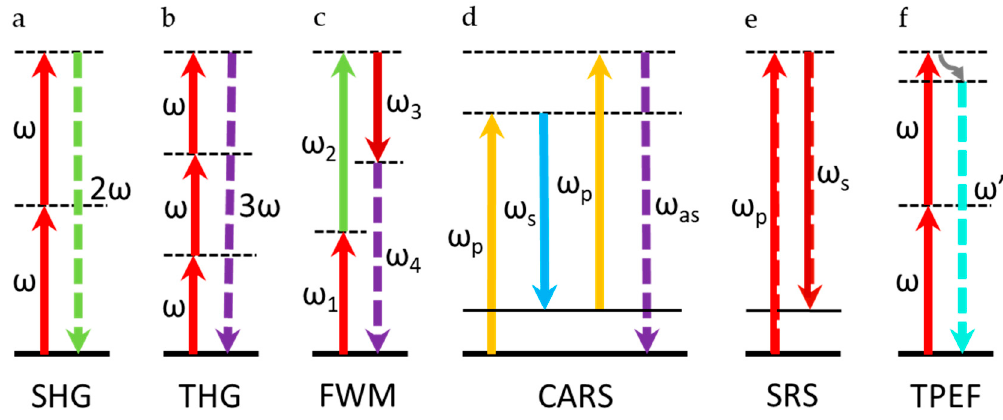
Figure 2. Energy diagrams of di ff erent nonlinear detection methods. In the figure, the thick black solid line represents the ground state, the thin black solid line represents the actual electron or vibration energy state, the dashed line represents the virtual state, and the solid arrow represents the incident excitation light. The arrow represents the signal light to be detected. ( a ) Second-harmonic generation (SHG) energy level diagram. ( b ) Third-harmonic generation (THG) energy diagram. ( c ) Four-wave mixing (FWM) energy diagram. ( d ) Coherent anti-Stokes Raman scattering (CARS) energy diagram. ( e ) Stimulated Raman scattering (SRS) energy diagram. ( f ) Two-photon excitation fluorescence (TPEF) energy diagram.